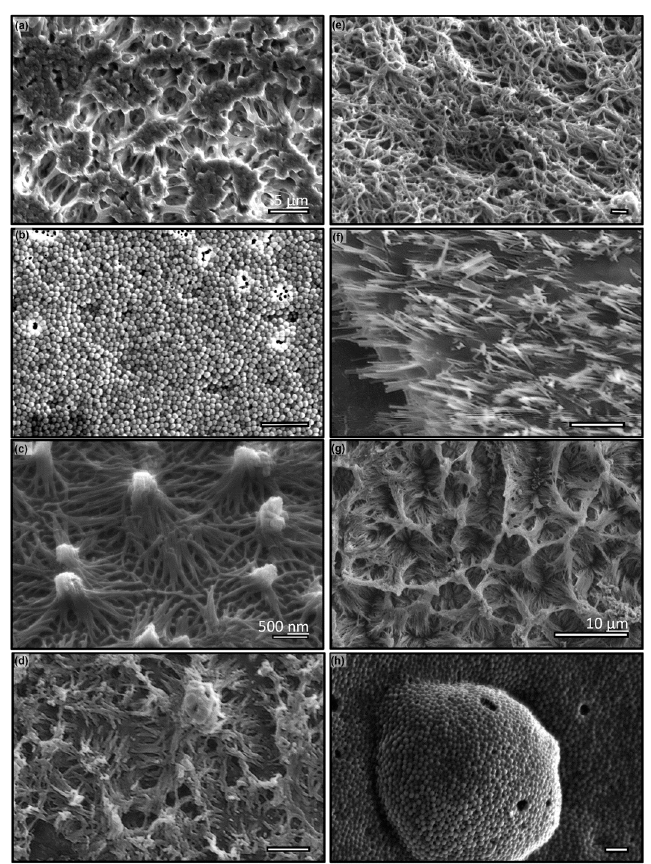
Figure 5. Sample of nanowires fabricated using vacuum molding over AAO template by various cross-linking polymers, ( a ) polydimethylsiloxane, ( b ) polyurethane (TC-9445) ( c ) epoxy, and ( d ) cyanoacrylate (crazy glue) and thermoplastic materials, ( e ) polyvinylidene fluoride, ( f ) polyamide, ( g ) polytetrafluoroethylene and ( h ) high-density polyethylene. The AAO templates used are 75 nm (a, c–d, g–h), 125 nm (b), and 55 nm (f). Scale: 1 µm or otherwise